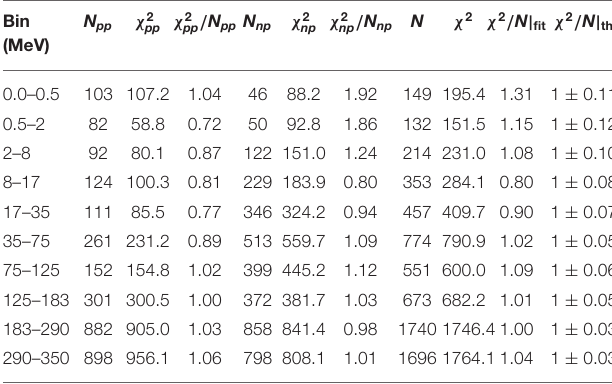
TABLE 4 | The χ 2 results of the main combined pp and np partial-wave analysis [60, 61] for the 10 single-energy bins in the range 0 < T LAB < 350 MeV. Bin (MeV)